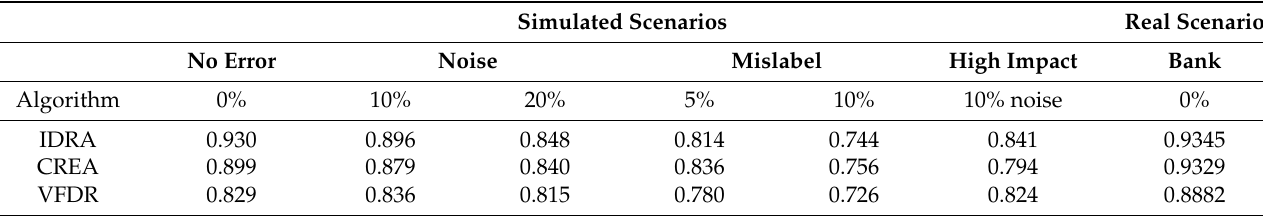
Table 3. Mean accuracy of